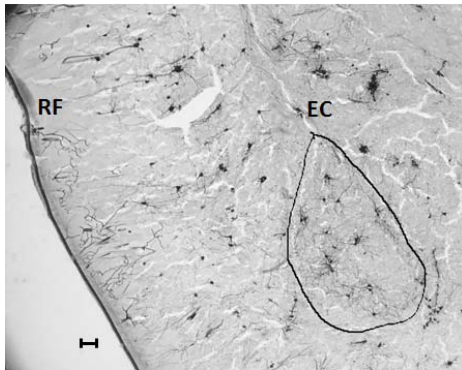
Figure 2. The region of interest sampled for dendritic arbors and spine density of the BLA neurons (bounded by black outline). RF denotes the location of the rhinal fissure, and EC denotes the location of the external capsule. The dorsal surface is towards the top of the figure and the medial surface is towards the right. Scale bar = 100 μ m).